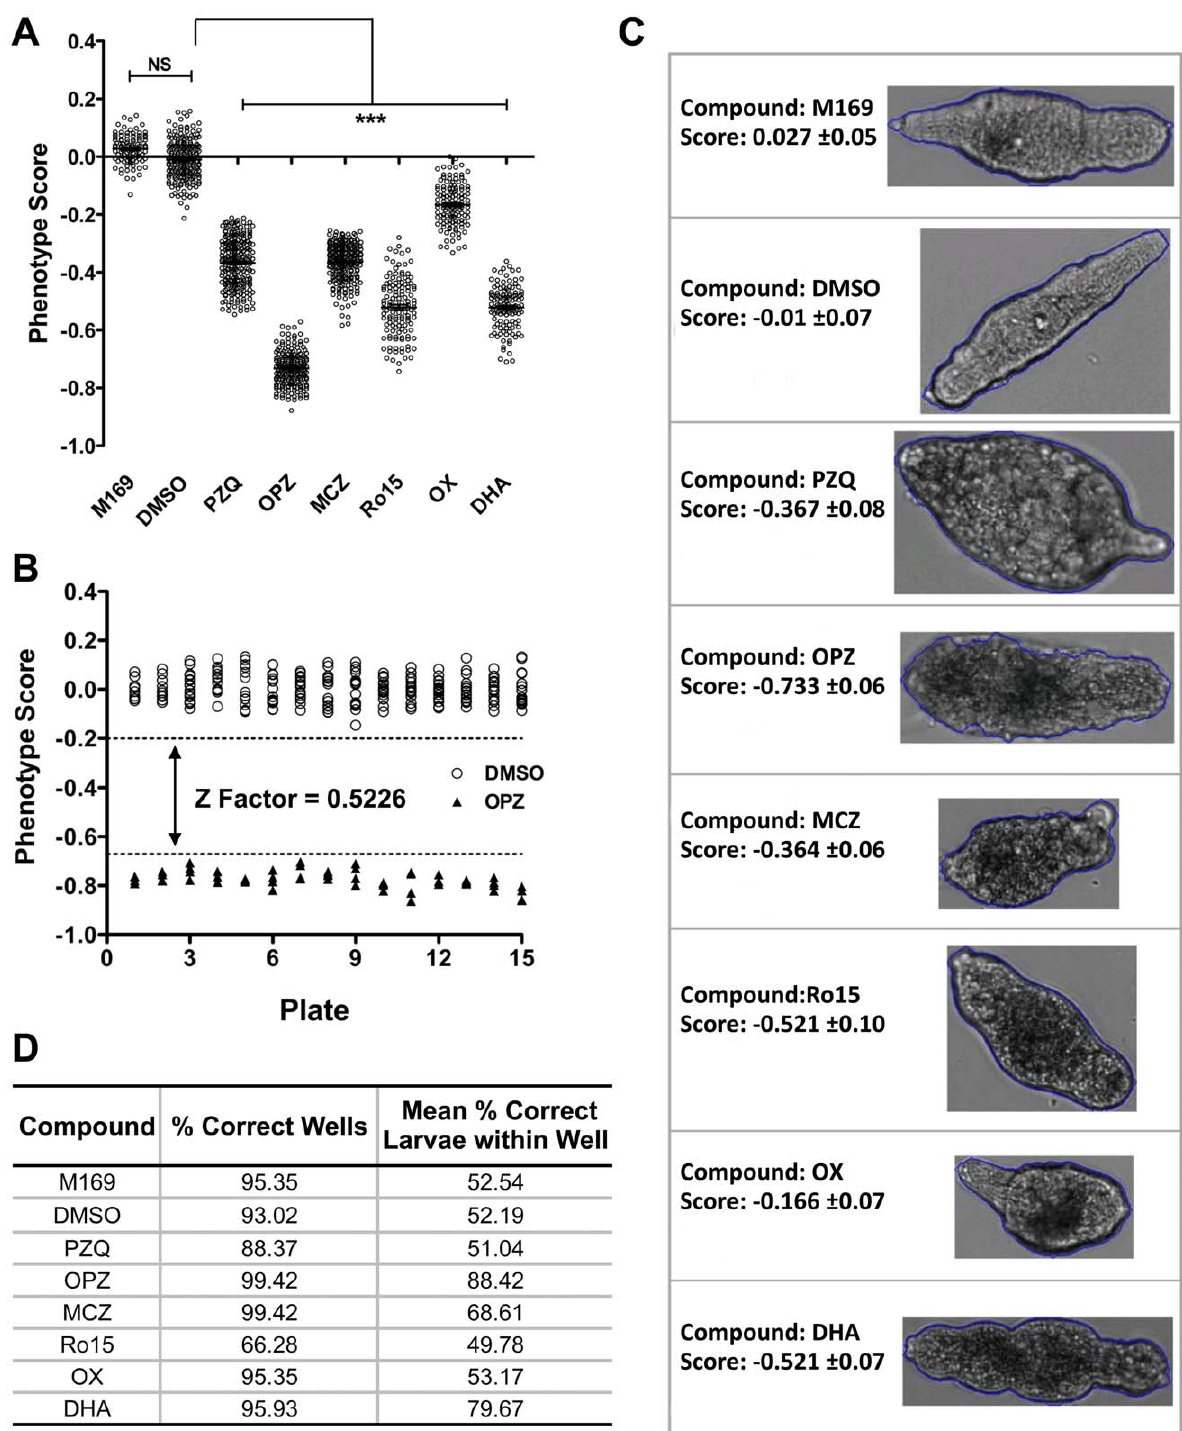
Figure 2. Automated image analysis of larval phenotype following treatment with anti-schistosome drugs. ( A ) Phenotype scores produced by the Bayesian prediction model from 5 replicate plates containing controls (M169/DMSO) or anti-schistosome drugs (10 m g/ml), praziquantel (PZQ), oltipraz (OPZ), methylclonazepam (MCZ), Ro15-5458 (Ro15), oxamniquine (OX) and dihydroartemisinin (DHA). N=120 wells per condition and significance values were measured by non-parametric one-way ANOVA with individual drug treatment being compared to the DMSO controls wells by a Dunn’s comparison post test, ***=p , 0.001. NS; not significant. ( B ) Z factor analysis based on the distribution of the negative (DMSO; circle) and positive controls (OPZ; triangle) from 15 analyzed plates of anti-schistosome compounds (dotted lines represent the upper and lower thresholds). ( C ) Typical larval phenotypes and phenotype scores induced by the anti-schistosome drug treatments or media (M169) and solvent (DMSO) controls. ( D ) Drug treatment class prediction for wells treated with the anti-schistosome drugs and the mean number of correctly predicted larvae per well.